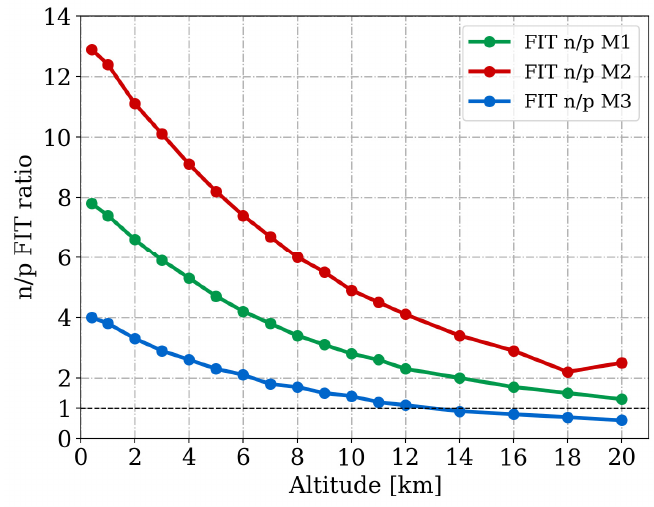
Figure 6. Ratio between neutron and proton FIT for the three methods (Alliance memory).